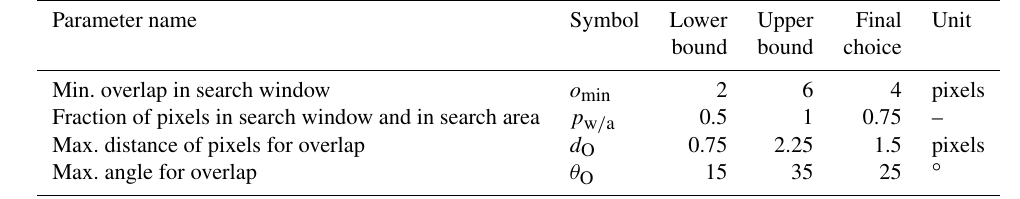
Table 2. List of parameters used in the LKF tracking algorithm. For each parameter the lower and upper bounds of the optimization are given along with the final choice of the parameter value.